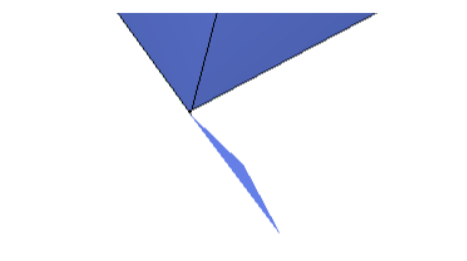
Figure 3. Polyhedral sliver created from IFC defined